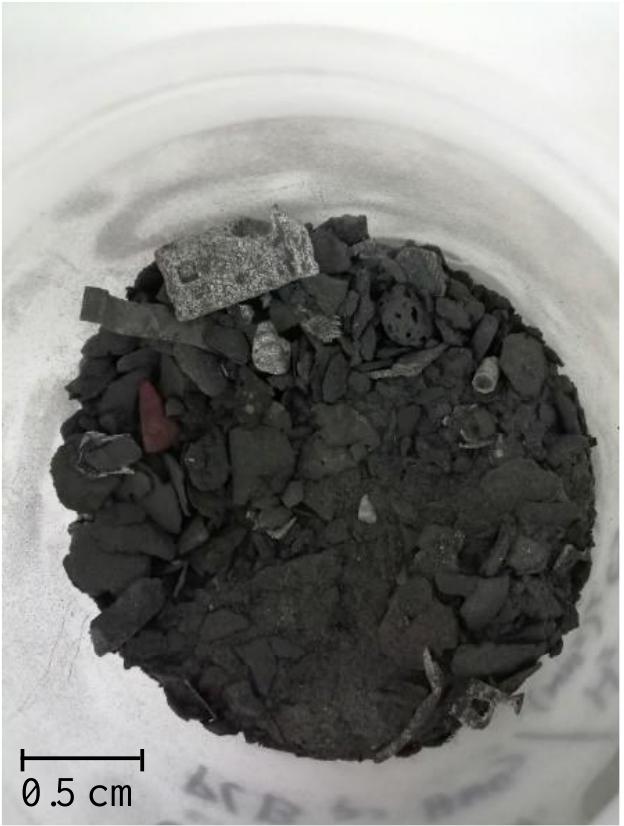
Figure 4. Solid WPCBs material after thermal pre-treatment and two steps of the II leaching with 5M HNO 3 and (4M H 2 SO 4 + 100 g/dm 3 (NH 2 ) 2 CS + 13 g/dm 3 Fe 2 (SO 4 ) 3 ), respectively.